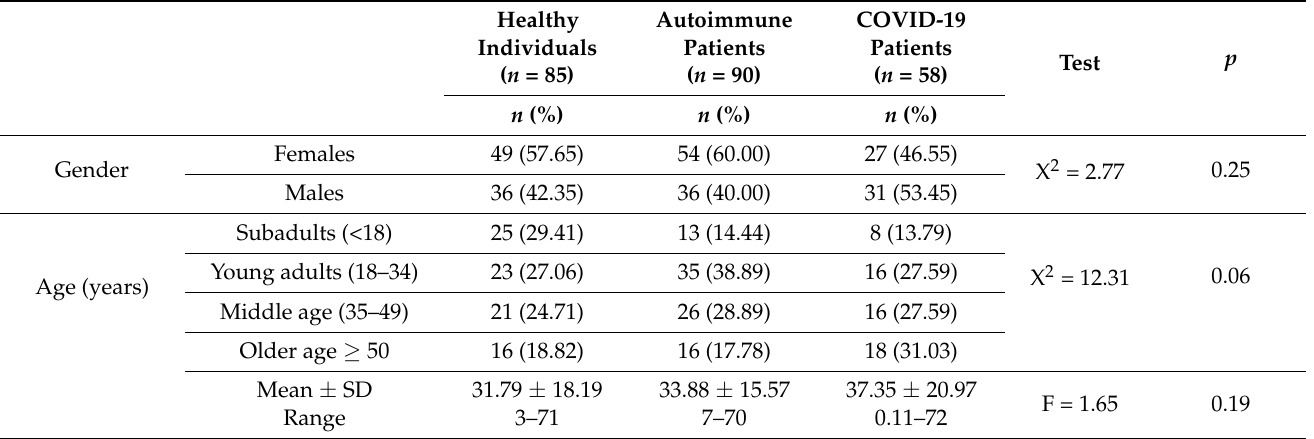
Table 1. Characteristics of the studied